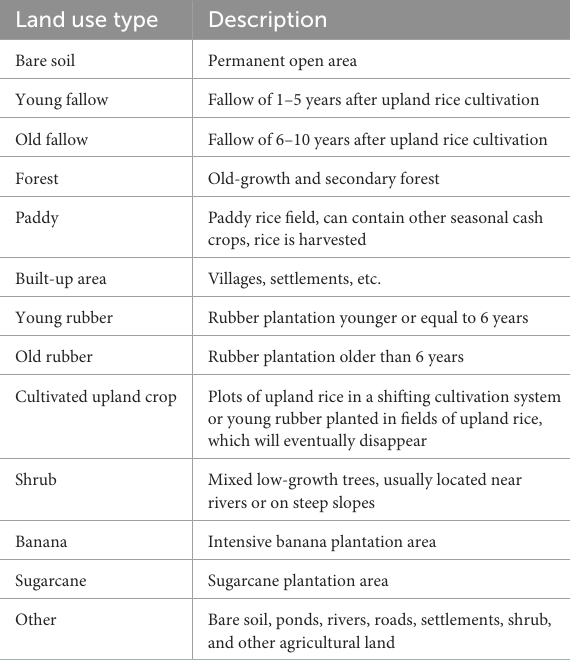
TABLE 1 Land use classification system. Land use type